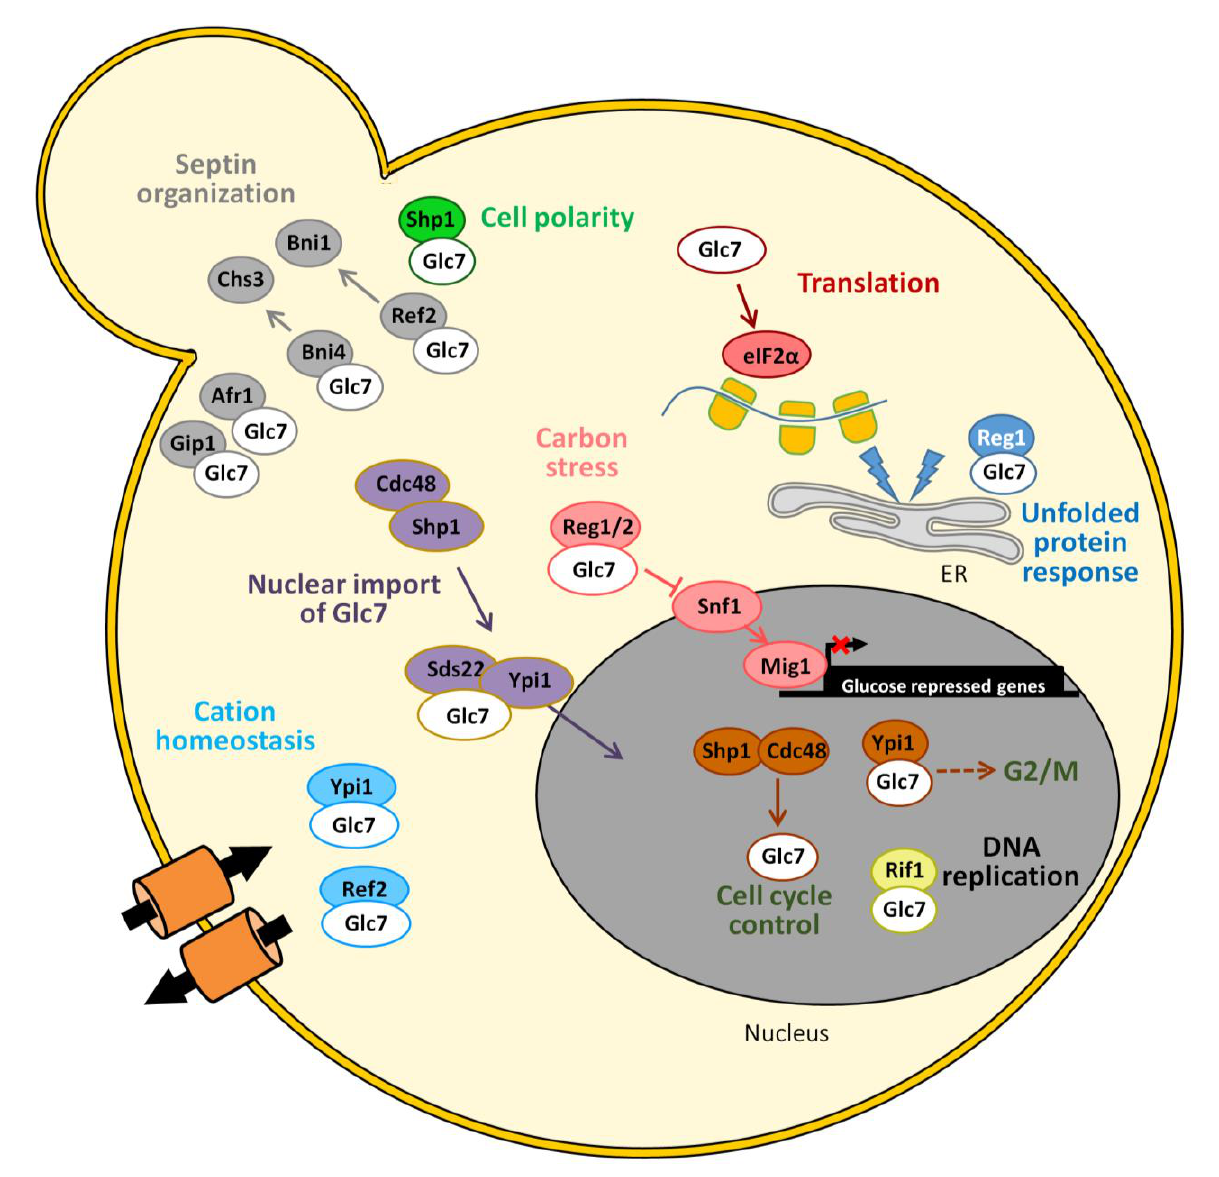
FIGURE 3: Schematic depiction of the diverse associations of Glc7 with its regulatory subunits and the functions in which the complex- es are involved . See main text for